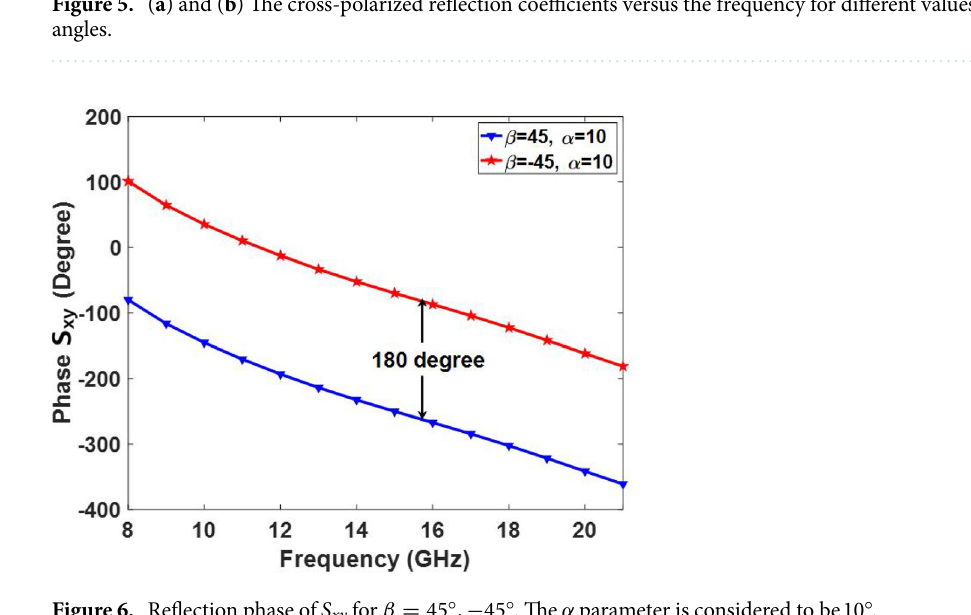
Figure 6. Reflection phase of S xy for β = 45 ◦ , − 45 ◦ . The α parameter is considered to be 10 ◦